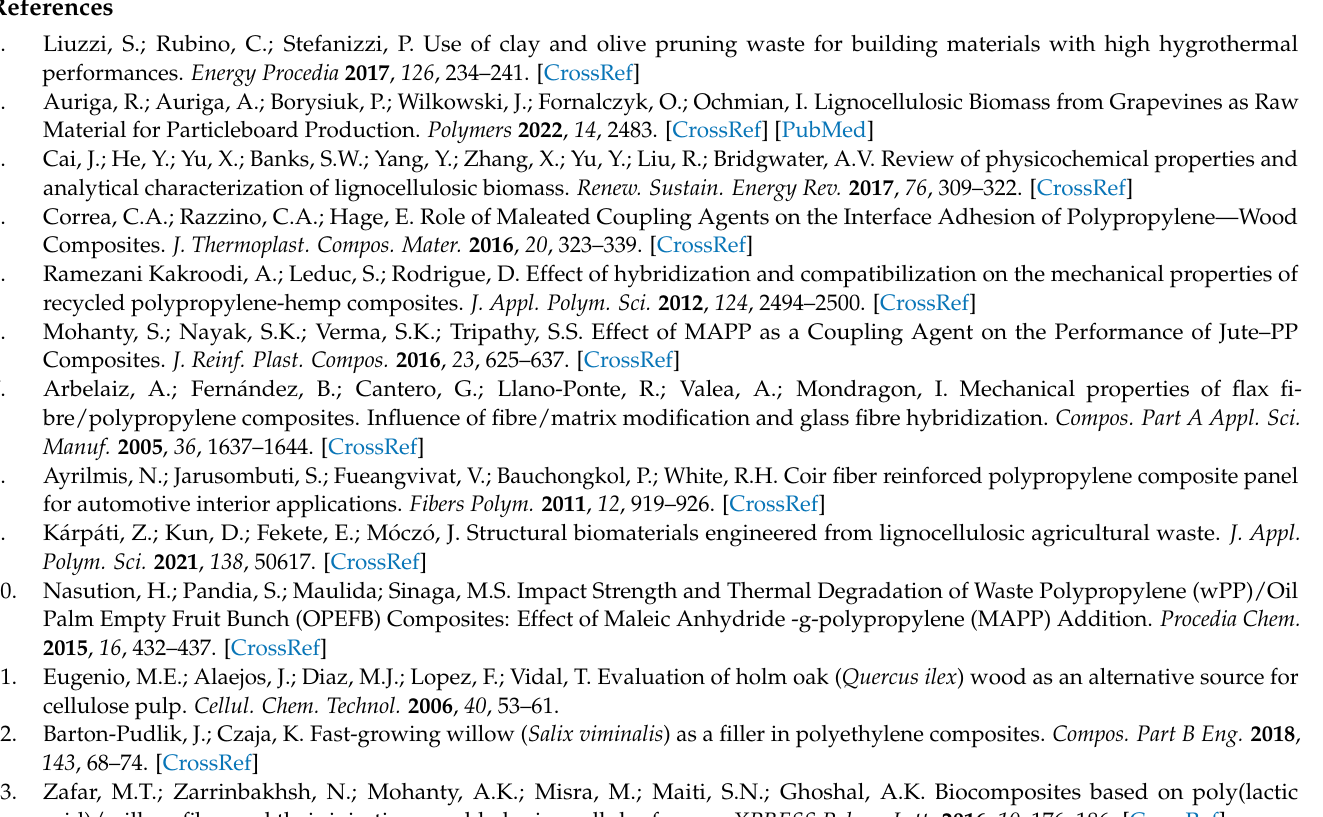
Figure A4. FTIR-ATR overlap of hemicellulose fractions of all biomasses: Licorice Root (L, red), Palm Leaf (P, blue), Willow (W, green) and Holm Oak (OH, black).